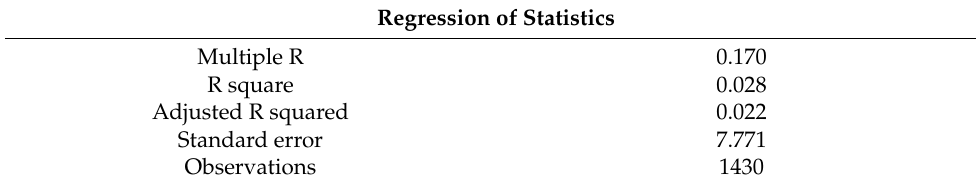
Table 6. Regression summary